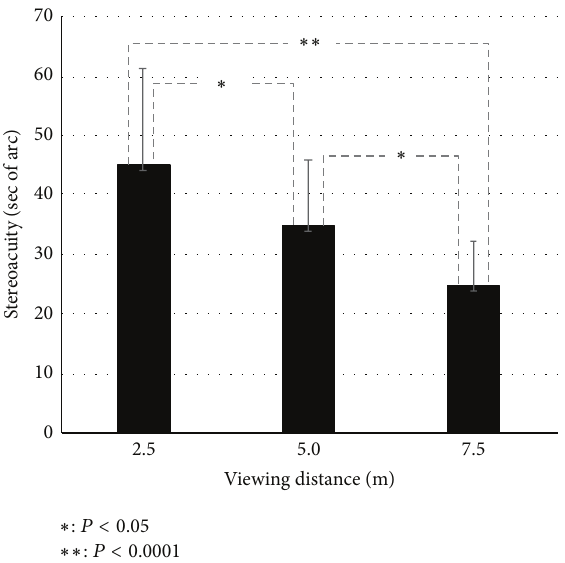
Figure 3: Average stereoacuity values for each target size. From the left of the graph, target sizes of 0.1 ∘ , 0.2 ∘ , 0.5 ∘ , and 0.9 ∘ are